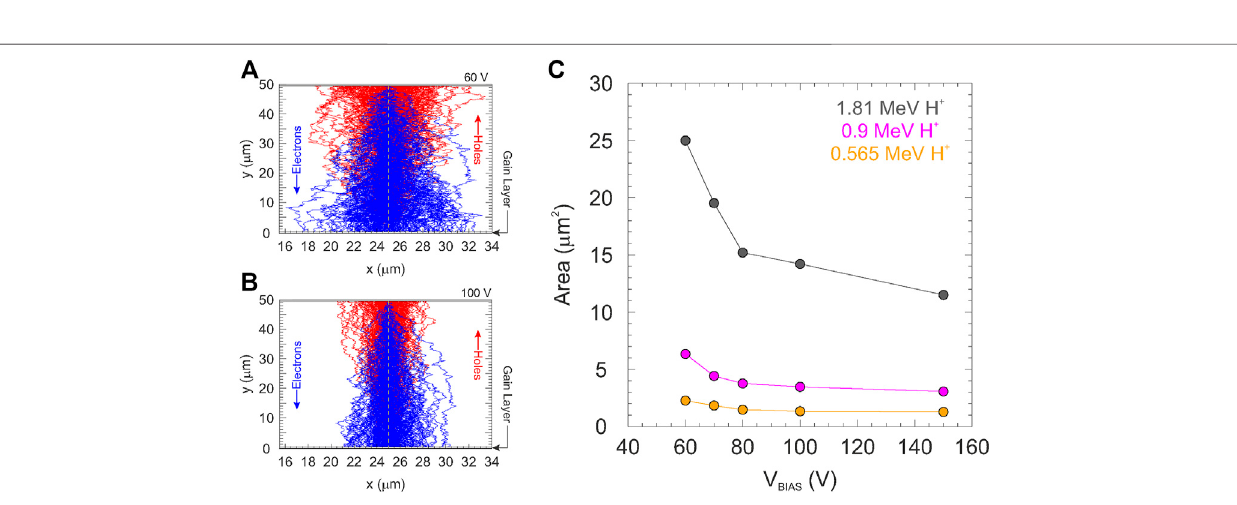
Frontiers in Physics |